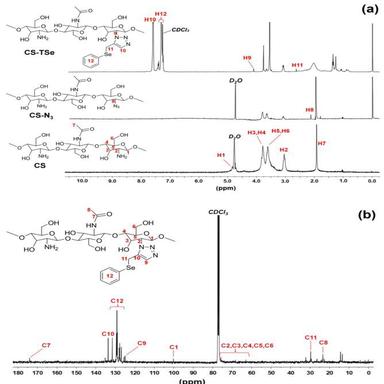
(a) 1 H NMR spectra of CS, CS-N3, and CS-TSe. (b) 13C NMR spectra of CS-TSe (Note: CS and CS-N3 spectra were recorded using D2O acidified with HCl and CS-TSe spectrum was recorded using CDCl3 as a solvent).